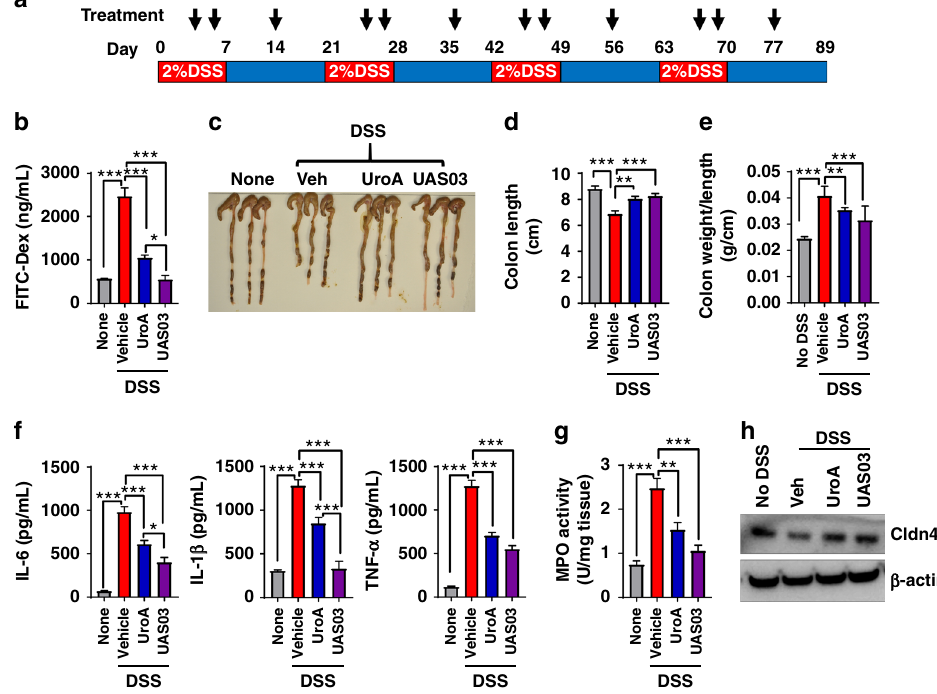
Fig. 6 Treatment with UroA/UAS03 mitigate DSS-induced chronic colitis. a C57BL/6 mice (7 – 8 week age old) were treated with four cycles of DSS (2%) with 7 days/cycle with an interval of 14 days with regular water. Control group of mice ( n = 5) received the regular water without DSS. UroA/UAS03 (20 mg/kg/day/body weight) that was resuspended in 0.25% sodium carboxymethylcellulose (CMC) solution ( n = 9) or vehicle (CMC) ( n = 9) was administered on 4th and 6th day of each DSS cycle and one treatment while on regular water. n = 5/control; n = 9/veh and UroA; n = 8/UAS03 group) Mice were euthanized at day 89 and the colitis phenotype was characterized. b Intestinal permeability using FITC-dextran was evaluated. c Representative colon images d colon lengths, e ratios of colon weight/length are shown. f Serum levels of IL-6, IL-1 β , and TNF- α were measured using ELISA methods. g MPO levels were determined in colon tissues. h Cldn4 expression in the colons of these mice ( n = 3) was measured by immunoblots. Statistics performed using unpaired t -test using Graphpad Prism software. Error bars, ±SEM *** p < 0.001; ** p < 0.01; * p < 0.05. Source Data are provided as a Source Data